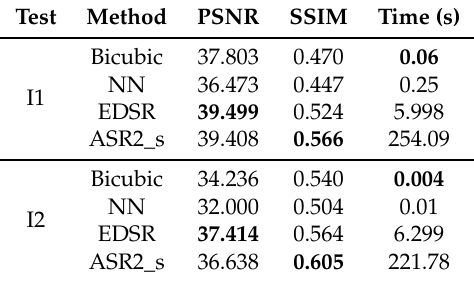
Table 1. Comparison among the proposed ASR2_s method, the nearest neighbor (NN), the bicubic interpolation (bicubic), and the EDSR methods in the case of SISR for the test images I1 and I2. PSNR and SSIM are defined by Equations (10) and (11), respectively; column “Time” represents the computation time in seconds. In bold we highlight the best values. Test